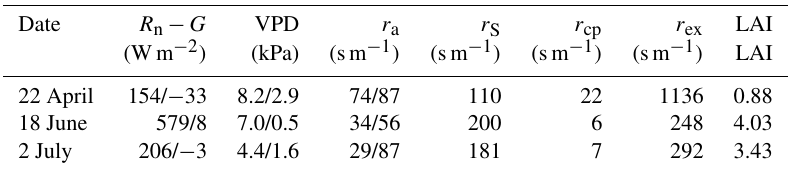
Table 1. Data used to compute T A − T S for the four extreme water and canopy conditions. Values before and after slashes (/) are data from midday and data from 1h after sunrise, respectively. Parameters are available energy ( R n − G ) where R n is net radiation and G is soil heat flux, vapor pressure deficit (VPD), aerodynamic resistance ( r a ) , resistance from air layer immediately above soil ( r S ) , canopy resistance at potential evapotranspiration ( r cp ) and maximum canopy resistance, associated with nearly complete stomatal closure ( r ex ) and leaf area index